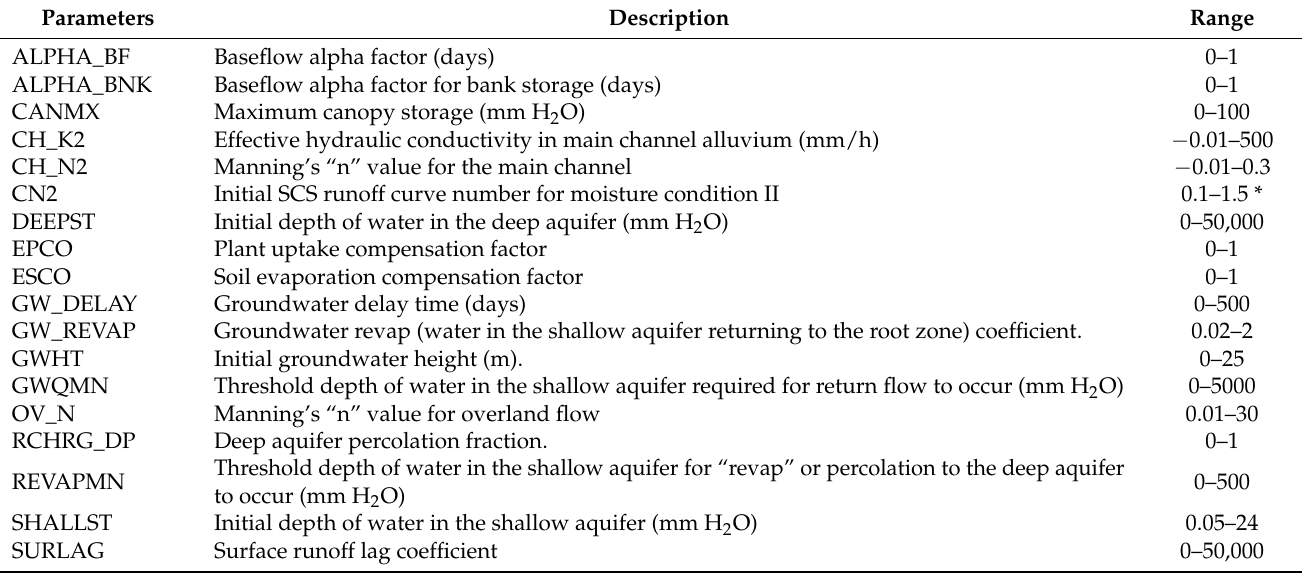
Table 2. Parameters used in